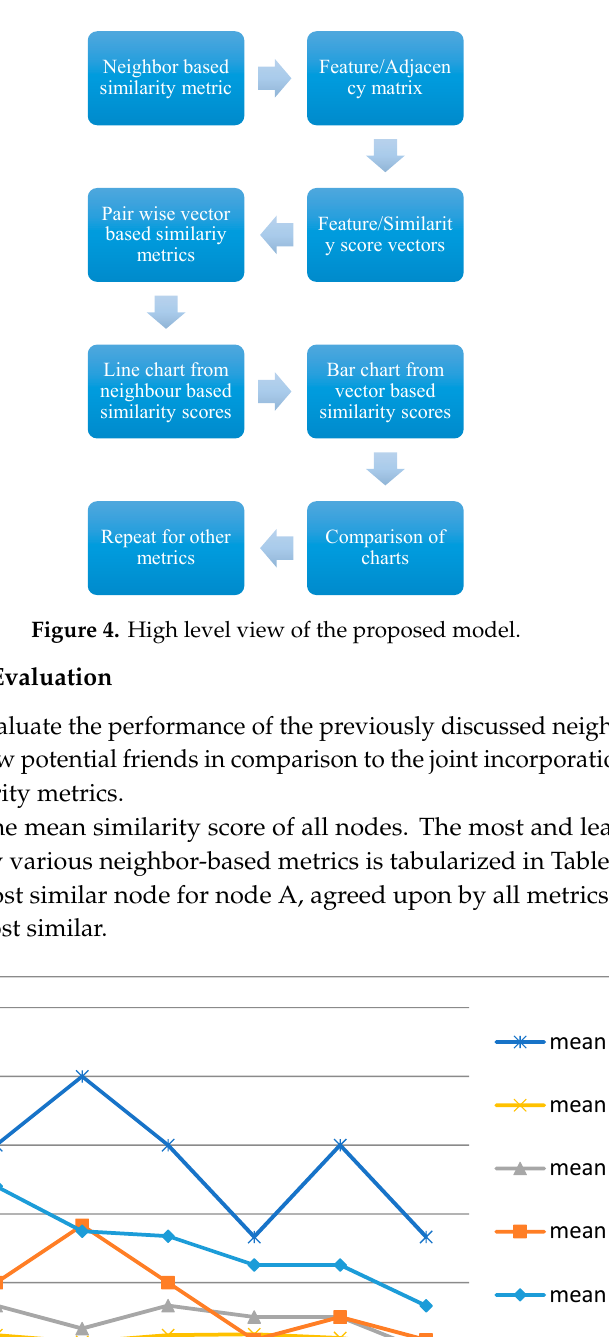
8 of 15 Figure 3. Weighted network graph. The adjacency matrix for edge weight measure is tabulated below. 𝑨 𝑩 𝑪